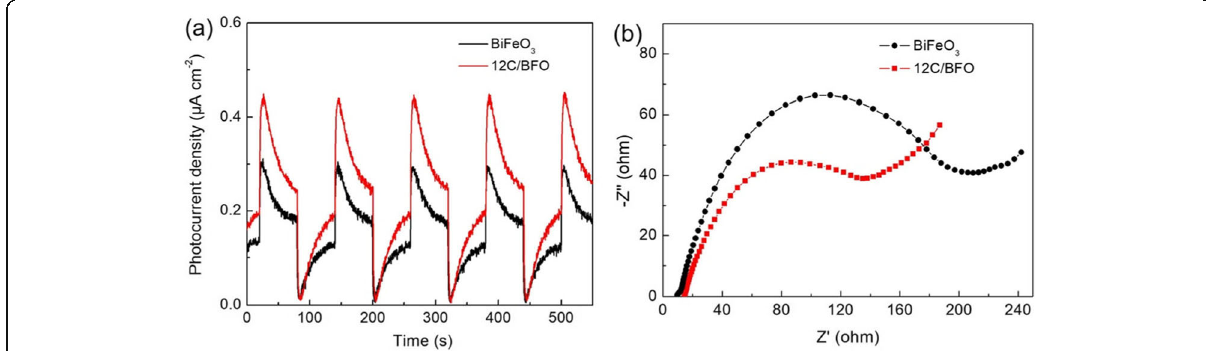
Fig. 12 a Photocurrent response plots of BiFeO 3 and 12C/BFO under visible light irradiation. b EIS spectra of BiFeO 3 and